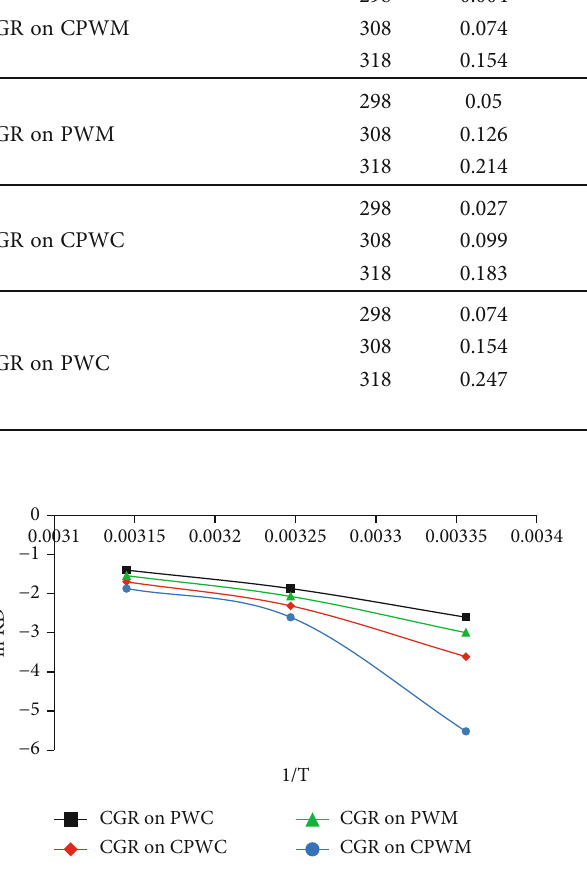
Figure 19: Nonlinear adsorption thermodynamic